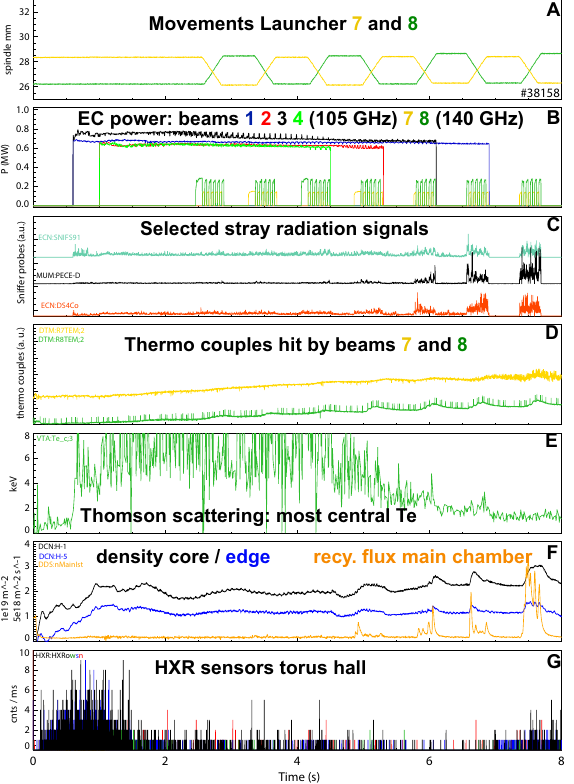
Figure 3. AUG #38158, I p : 800 kA, B t : -1.7 T. See text for detailed discussion.